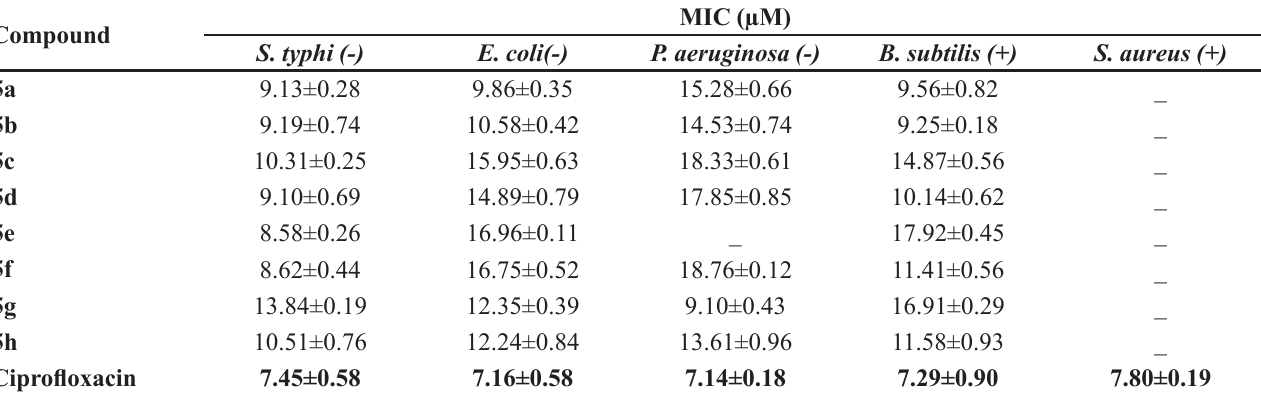
TABLE III - Antibacterial activity (MIC) and hemolytic activity of the different 2-furyl(4-{4-[(substituted)sulfonyl]benzyl}-1- piperazinyl)methanone derivatives ( 5a-h )